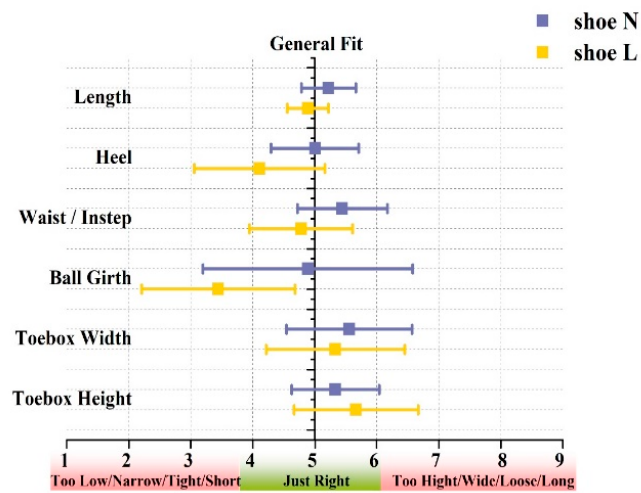
Appl. Sci. 2019 , 9 , x FOR PEER REVIEW Figure 6. E ff ect of di ff erent basketball shoes (N vs. L) on general fit. Figure 6 . Effect of different basketball shoes (N vs. L) on general fit .